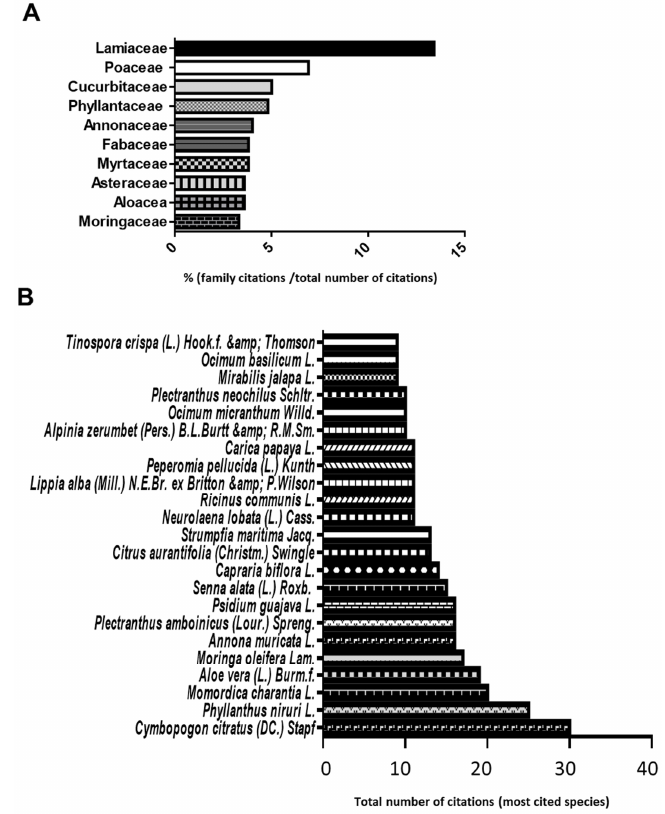
Figure 2. Medicinal plants identified in the ethnopharmacological survey: ( A ) botanical families predominantly used in Grand-Terre and ( B ) number of citations for each plant. To evaluate the relative relevance of a plant species in folklore medicine in the area of study, we used the use value (UV) [29,30]. Cymbopogon citratus (DC.) Stapf (5.7% or 30/523), Phyllanthus niruri L. (4.8% or 25/523), and Momordica charantia L. (3.8% or 20/523) were the most cited plants and had the highest UV (Figure 3). Cymbopogon citratus (DC.) Stapf is used by more than 1 out of 4 participants (UV = 25.4% or 30/118), Phyllanthus niruri L. is used by more than 1 participant out of 5 (UV = 21.2% or 25/118) and Momordica char- antia L. is used by more than 1 out of 6 participants (UV = 16.95% or 20/118).